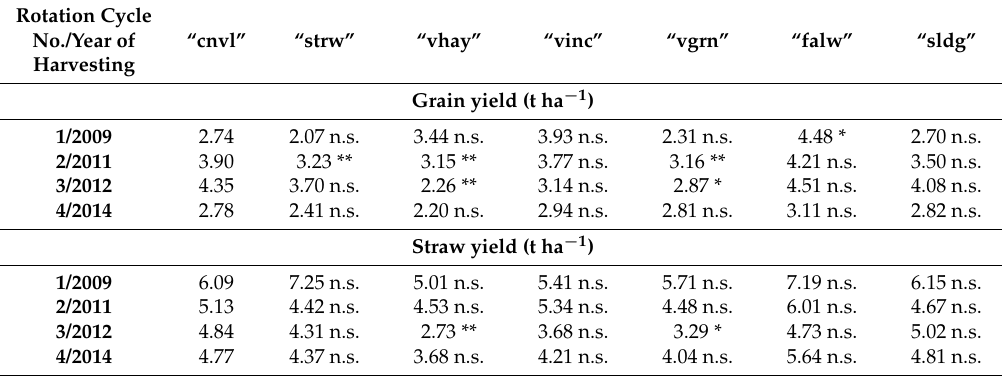
Table 4. Treatment effects on wheat yields and N concentration and uptake at the third year of each rotation cycle (“residual effect years”). Statistical analysis results appearing at the right side of values refer to the comparison between treatments and the